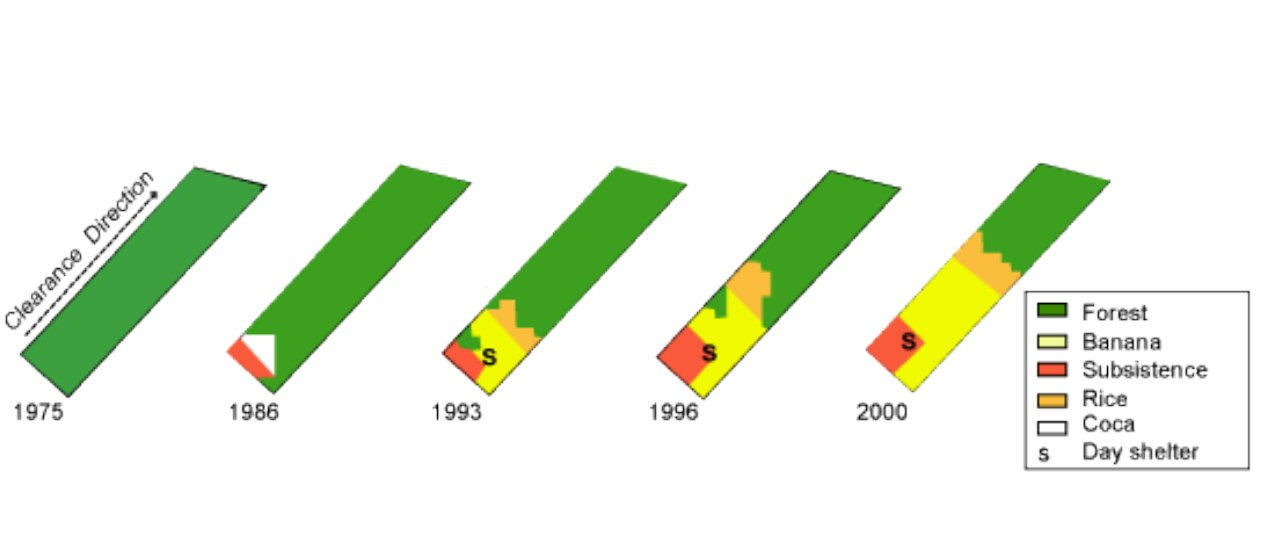
Fig. 4. A sequence of land-use maps illustrating a farm from Community I where coca was grown and then abandoned in favor of substitute